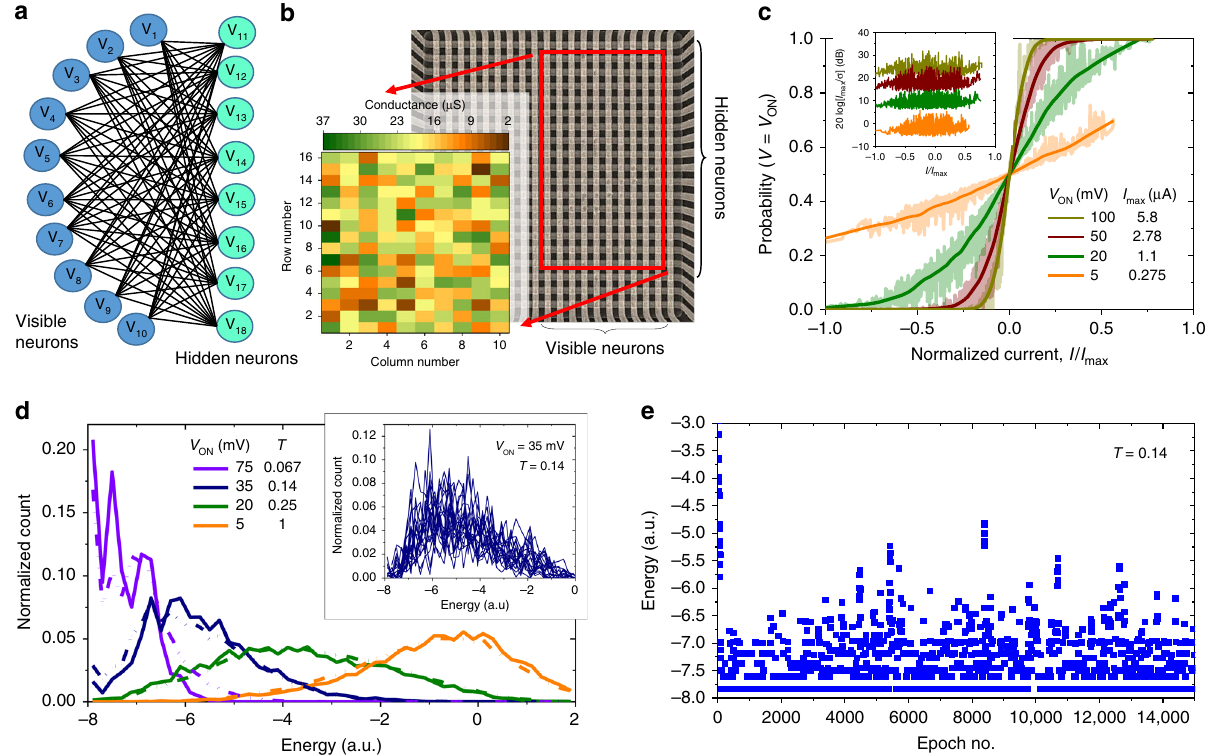
Fig. 2 Memristor-based restricted Boltzmann machine. a A bipartite graph of the considered RBM network and ( b ) its implementation with passively integrated metal-oxide memristors. The red rectangle highlights the utilized area of 20×20 crossbar array, while the inset shows the conductance map, measured at 50mV, after programming devices to the desired states. Note that though the neurons in Boltzmann machine are typically partitioned into visible and hidden ones, for simplicity, we use the same notations for both types. c Measured stochastic neuron transfer functions at several V ON , i.e., different effective computing temperatures, for the hidden neuron #2 of the implemented network, which is attached to rows #3 and #4 of the crossbar circuit. The inset shows peak signal-to-noise ratios across full range of neuron ’ s input currents. I max corresponds to the largest input current to the neuron #2. Some minor, unwanted SNR dependence on the input current is due to the artifacts of the experimental setup. d Measured (solid) and modeled (dash-dot) energy distributions. The inset shows measured energy distributions for the speci fi c temperature, collected over 20 different 1000-epoch spans. e An example of the simulated evolution of energy for the speci fi c temperature. All neurons are initialized to zero state at the beginning of this simulation. In all experiments, the neuron ’ s input currents were sampled at 1MHz bandwidth, while integrating noise above this frequency. On panels ( d ) and ( e ), the temperature is computed relative to the largest possible current, which corresponds to all ten differential synaptic weights set to the maximum value of 32 µ